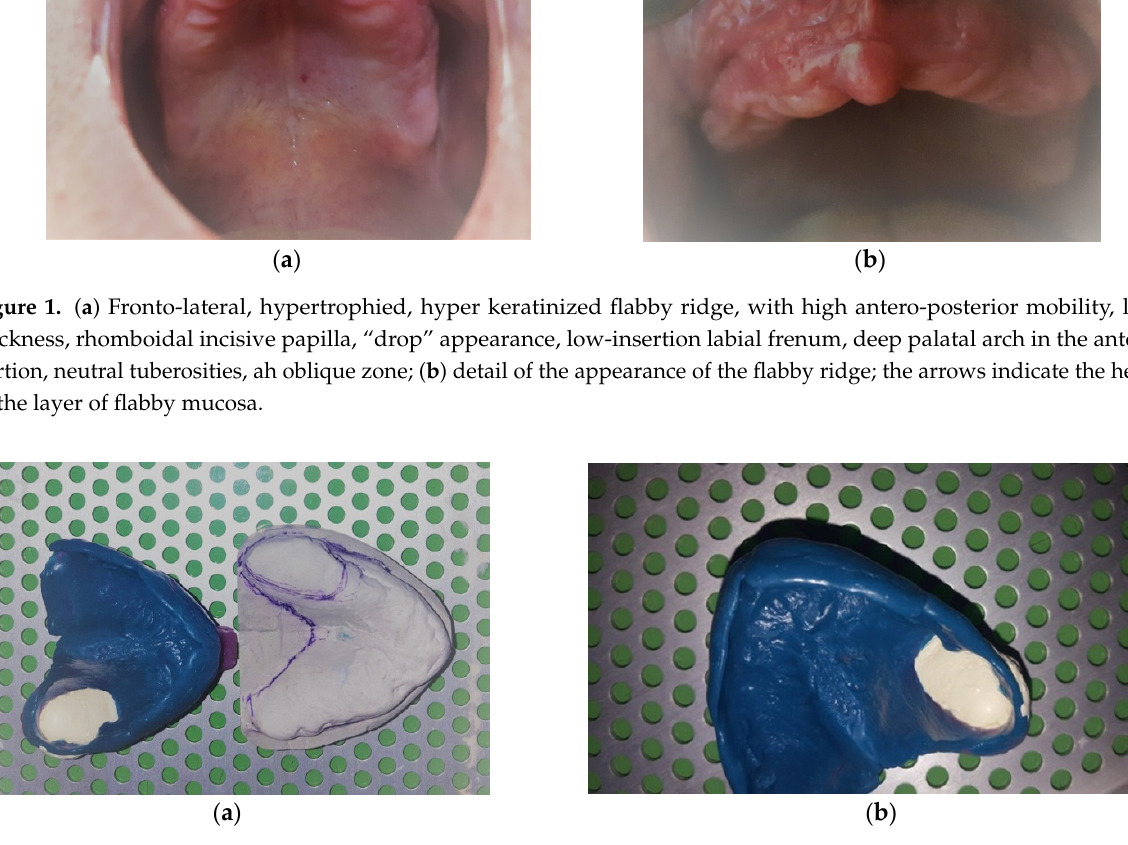
( b ) Figure 3. ( a ) Maxillary prosthetic field, with well-formed high ridges, voluminous tuberosities, slightly retentive ves- tibulo-distal, voluminous maxillary torus located posterior, flabby ridge apparently normal histological appearance at inspection, but with increased mobility; ( b ) lower prosthetic field with flabby ridge in the lower frontal area, atrophic, with hyperplasia of the vestibule groove by continuous trauma due to the edge of a lower prosthesis without mainte- nance and stability. The preliminary impression was recorded in two of the patients using old dentures as trays, and in the third using standard trays and irreversible hydrocolloid (Tropical- gin-Zhermack, (Germany)Germany. The custom trays were made of light-cured base material fenestrated in the areas of the flabby mucosa, after the adaptation of the custom tray on the prosthetic field at the level of the peripheral suction areas by the “step by step” method. Depending on the concept behind the impression techniques, they can be classified into: mucostatic, mucodynamic, with open or closed mouth, compressive or non-compressive, with one or more materials, in one or multiple steps.[18]. Our method for final impression was: mucodynamic, two steps, open mouth, non-compressive, compound, by using at least two impression materials. The final impression was performed experimentally in three ways, using low vis- cosity impression materials so as not to compress the prosthetic field and moreover to record the flabby mucosa in a resting position. For the first patient, we used: zinc ox- ideeugenol paste brushed on the flabby mucosa (Repin-Spofa Dental, Czech Republic) and fluid condensing silicone (Oranwash-Zhermack, Germany) for the rest of the pros- thetic field; for the second patient: zinc oxideeugenol paste brushed for flabby tissue and fluid condensing silicone with superior properties similar to addition silicones (Speedex-ColteneWhaledent), and for the third, fluid self-mixing addition silicone